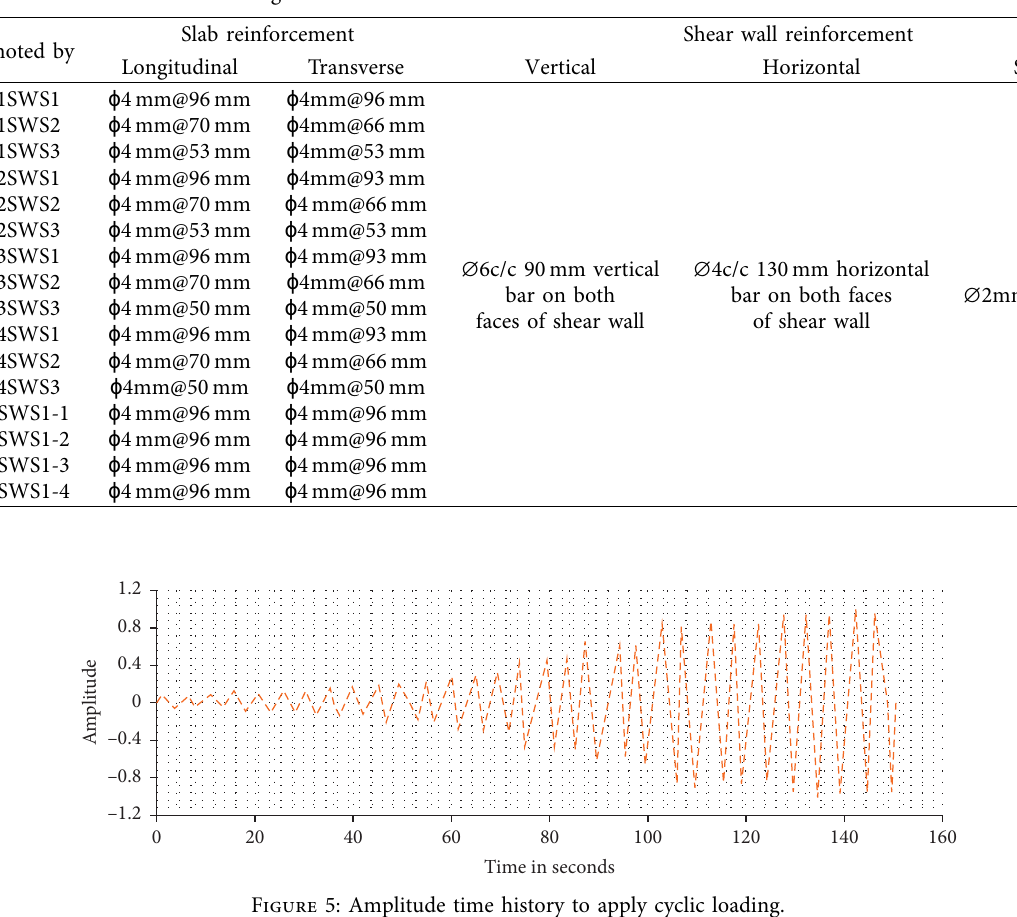
Table 3: Detailing for both reinforced concrete slab and shear wall for the